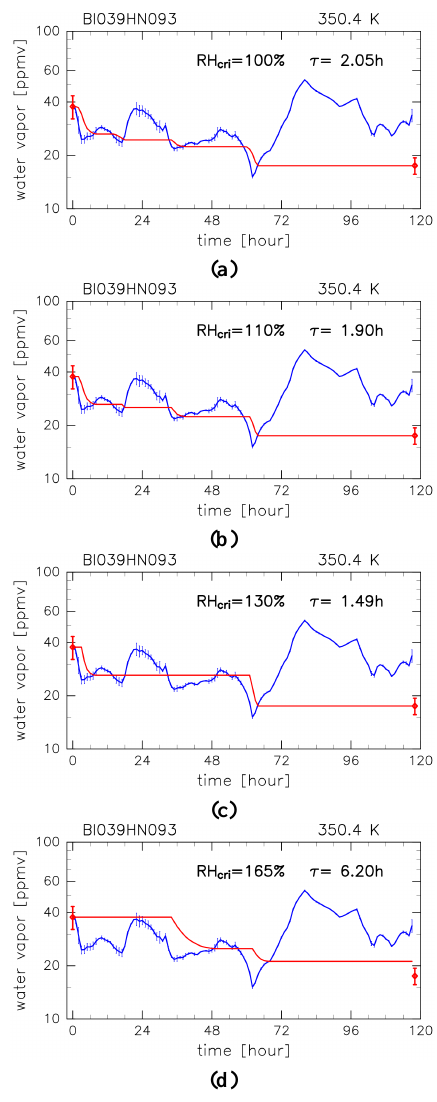
Fig. 10. Dehydration scenarios showing the time evolution of the water vapor mixing ratio of the air mass (red line) and exposed SMR (blue line) estimated from the match case shown in Fig. 7. The value of τ stated in each panel is the estimated relaxation time of conden- sation for the assumed values of RH cri , which are (a) 100%, (b) 110%, (c) 130%, and (d)